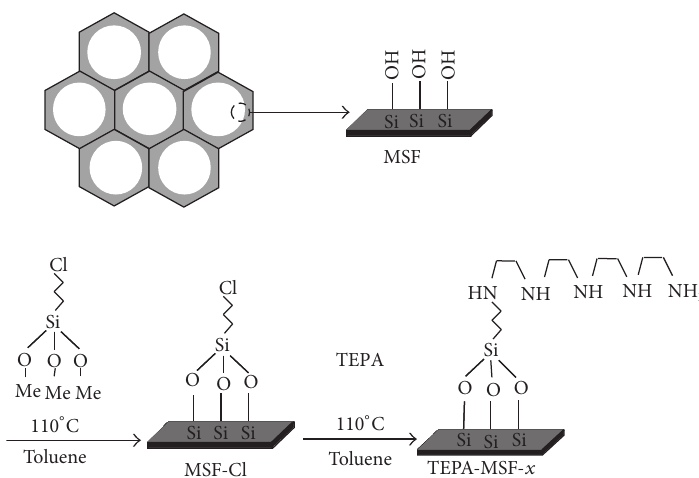
F 1: Scheme of preparation of TEPA-modi�ed MSF by a chemical graing